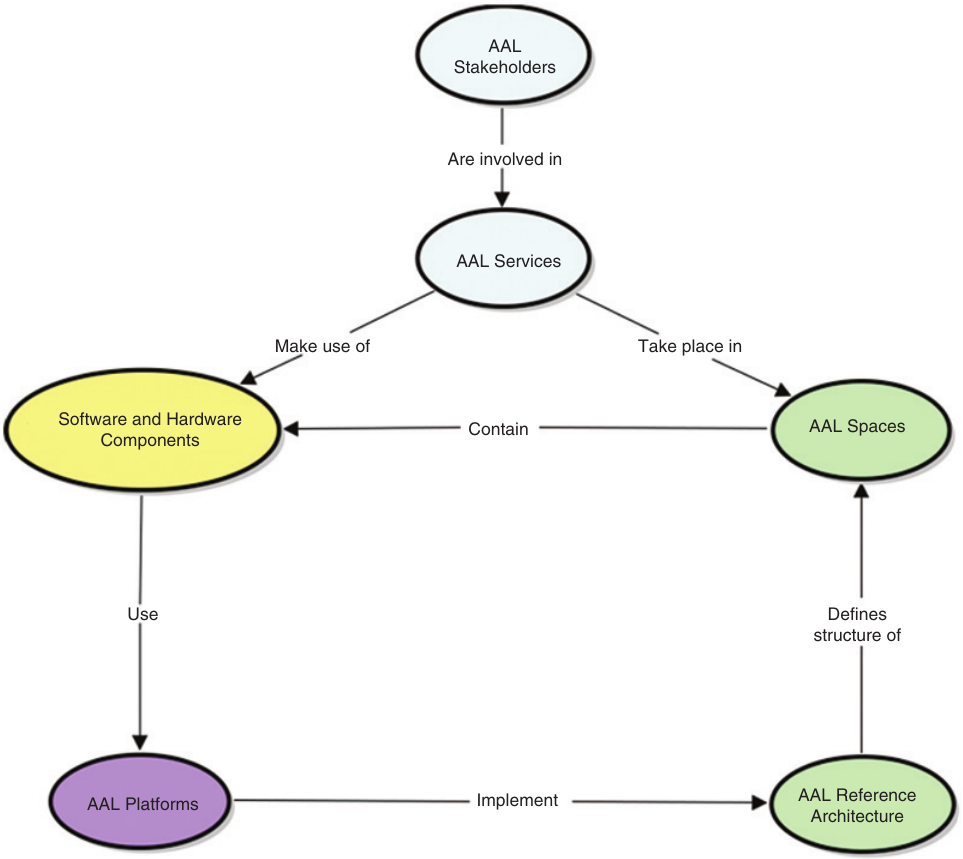
Figure 2: Root Concept Map of the AAL